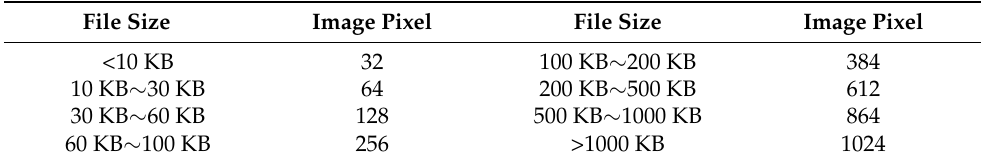
Table 1. Image width for various file